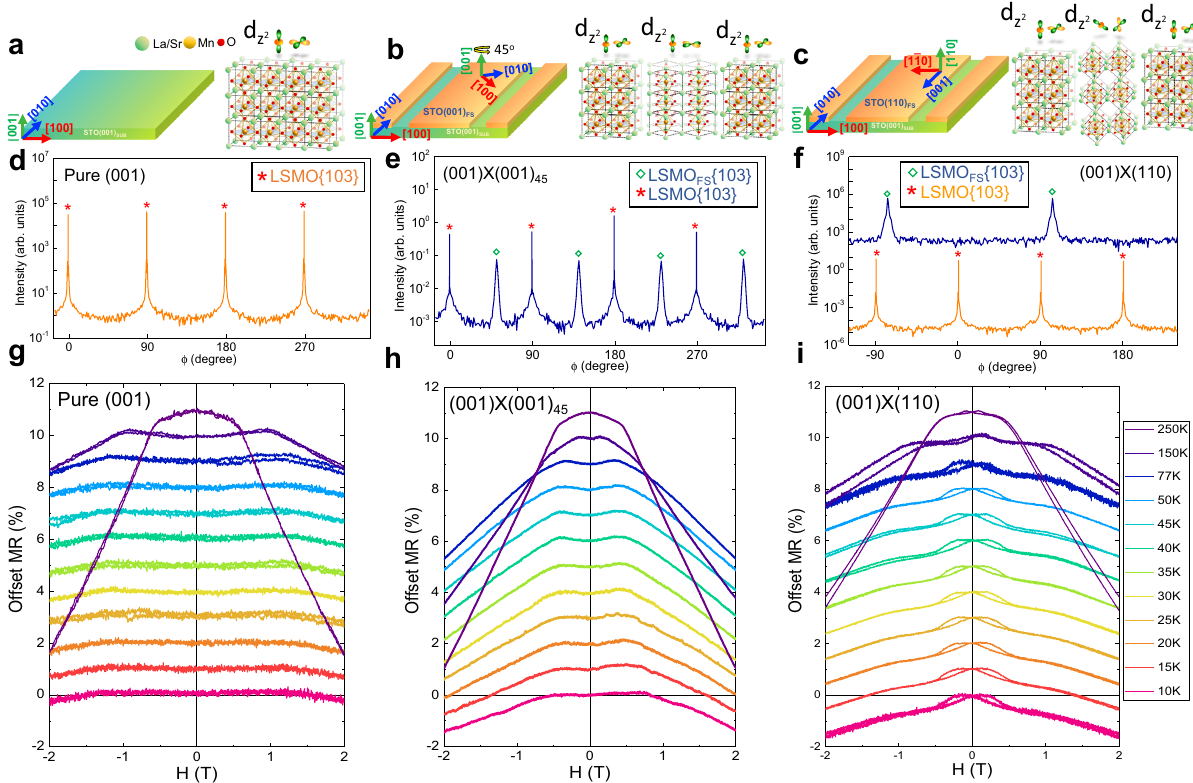
Fig. 5 Magnetotransport on multijunction LSMO lateral homostructures with alternating orbital con fi gurations. a – c Schematic illustrations (left) of ( a ) reference (001)-oriented STO substrate, ( b ) twisted array template composed of alternating (001)-oriented STO substrate and FS-STO layers rotated by 45 degrees in-plane, and ( c ) twisted array template composed of alternating (001)-oriented STO substrate and (110)-oriented FS-STO layers. The designed lattice and representative d z 2 and d x 2 - y 2 orbital of LSMO after deposition are illustrated in the right panels. d – f Corresponding in-plane X-ray phi scan of {103} re fl ections of LSMO grown on templates shown in ( a – c ). Temperature-dependent transport measurements of ( g ) pure (001), ( h ) (001) x(001) 45 LSMO, and ( i ) (001)x(110) LSMO homostructures. The magnetoresistance changes are de fi ned as ( ρ H − ρ o / ρ o ) × 100 (%). The external magnetic fi eld is applied along [001] direction of STO